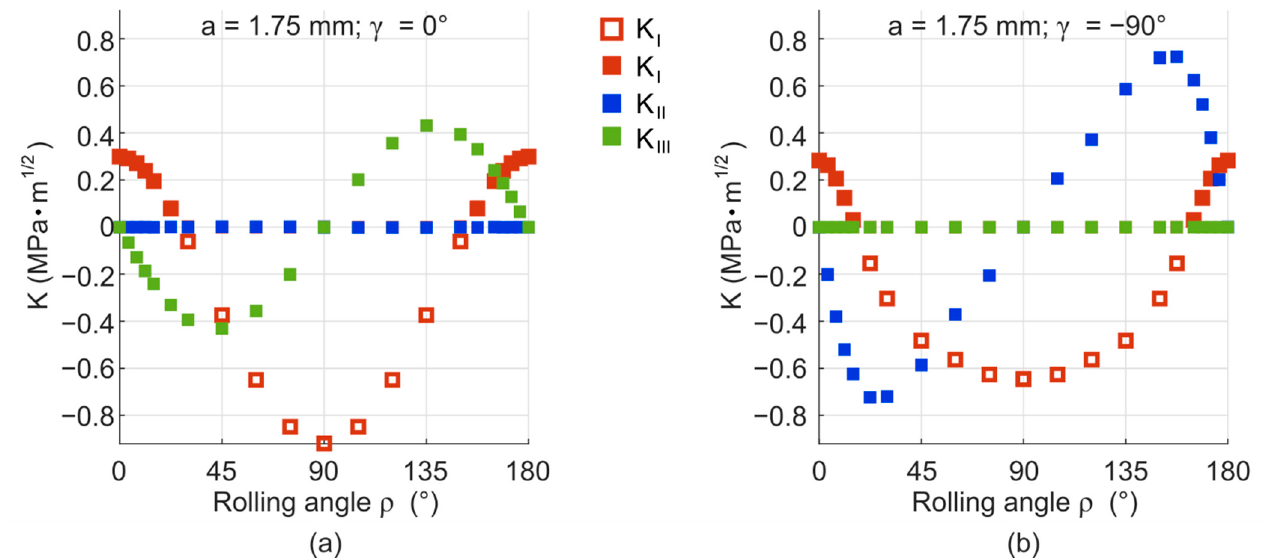
Figure A6. Course of stress intensity factors during rotation in the cylinder D × L = 6 × 6 mm 2 , load F = 350 N, a = 1.75 mm, position on the crack front; ( a ) γ = 0°; ( b ) γ = − 90°.